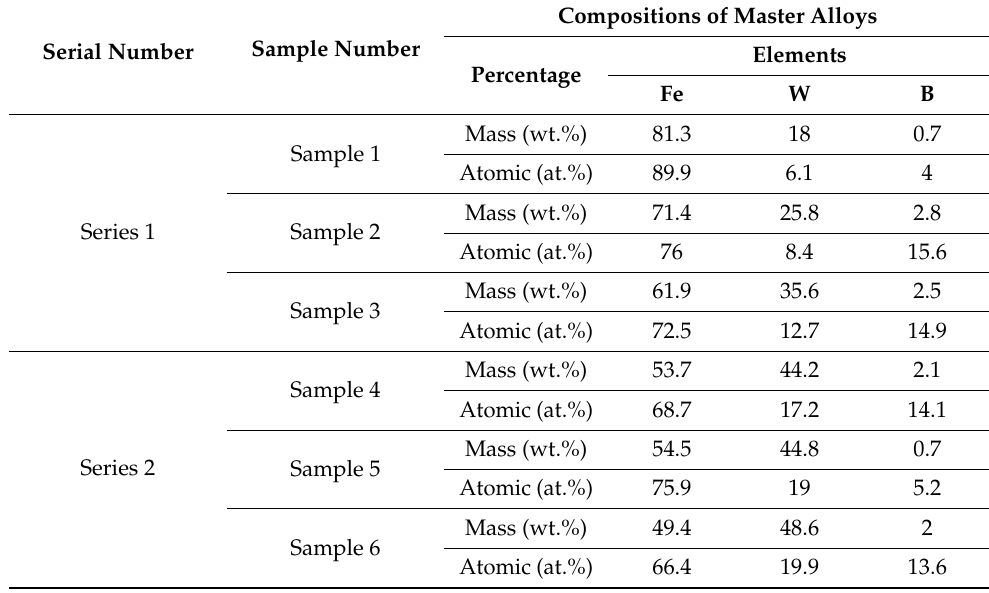
Table 1. Compositions of Fe-W-B master alloys used in this work.